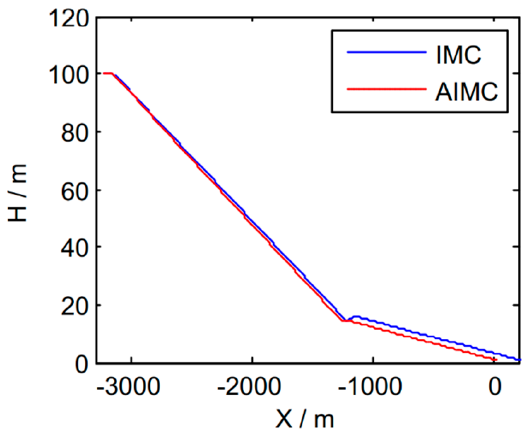
Figure 13. Pitch angle in windward conditions.